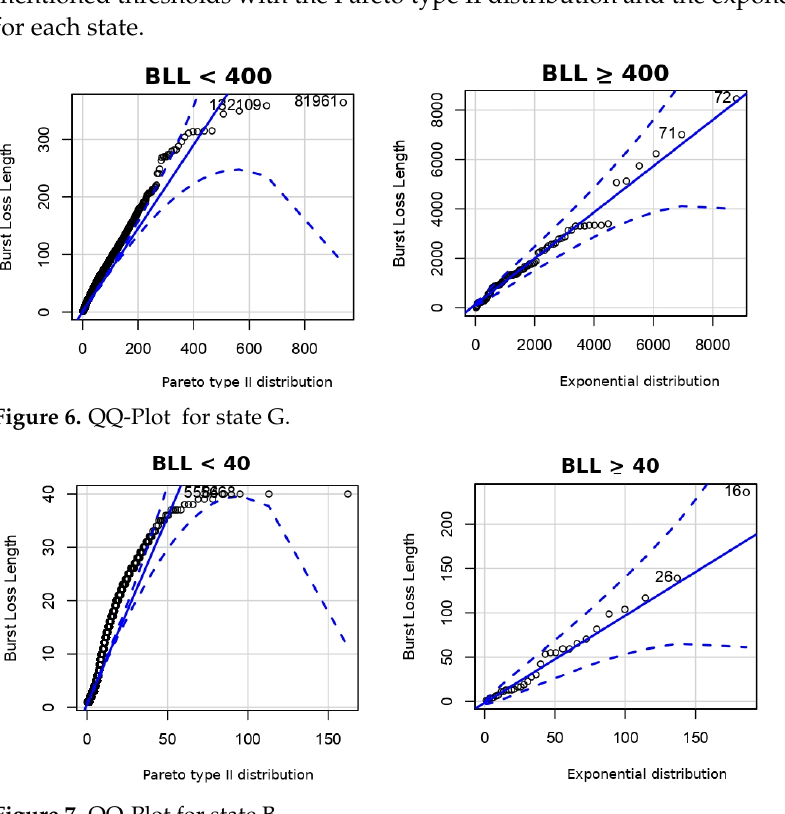
Figure 7. QQ-Plot for state B.